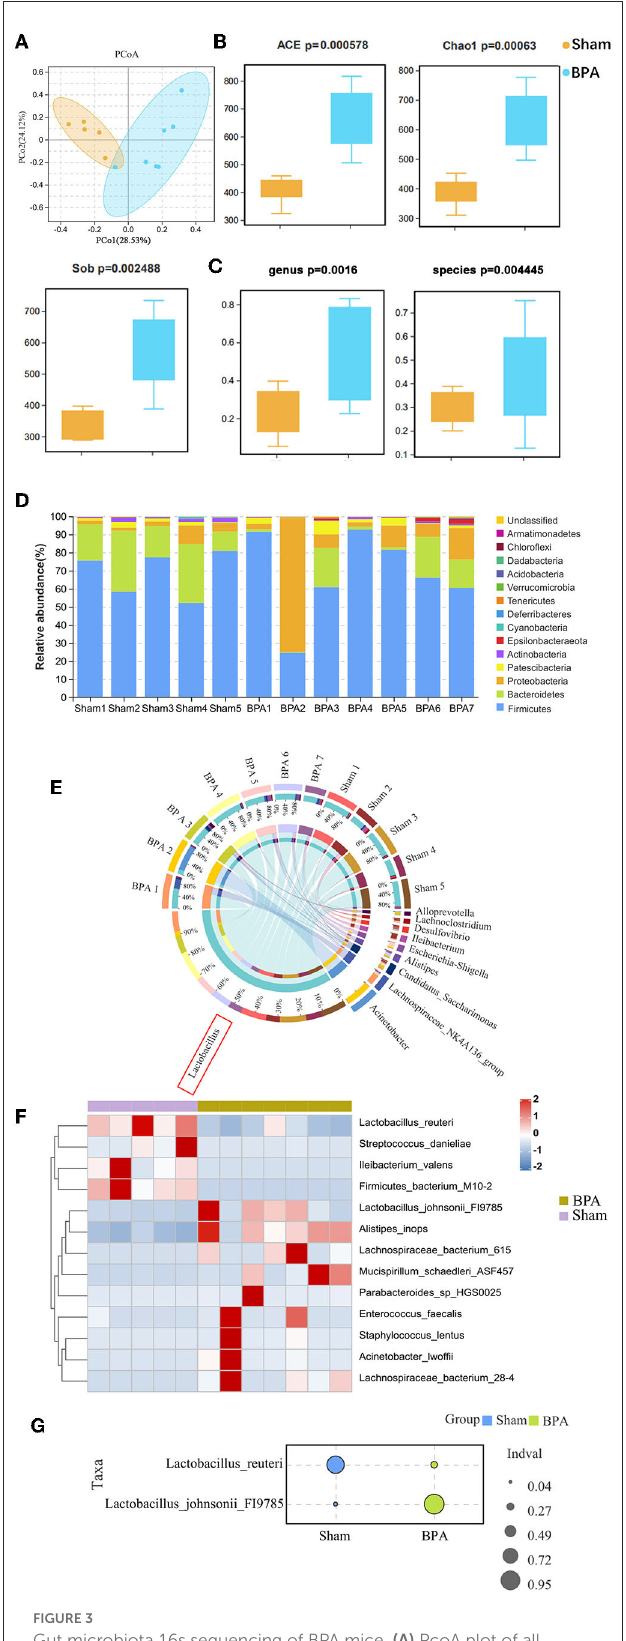
FIGURE3 Gut microbiota 16s sequencing of BPA mice. (A) PcoA plot of all samples. (B) α diversity of ACE, Chao1, and Sob indices of the gut microbiota in the two group (C) β diversity analysis of the samples in the two groups at the genus and species level. (D) Relative